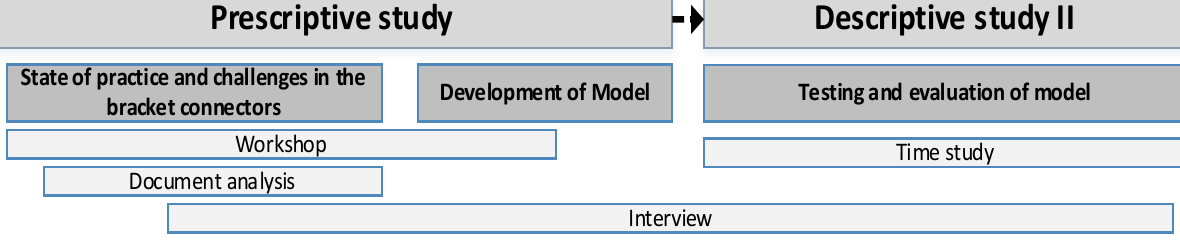
Figure 1. Our workflow process.